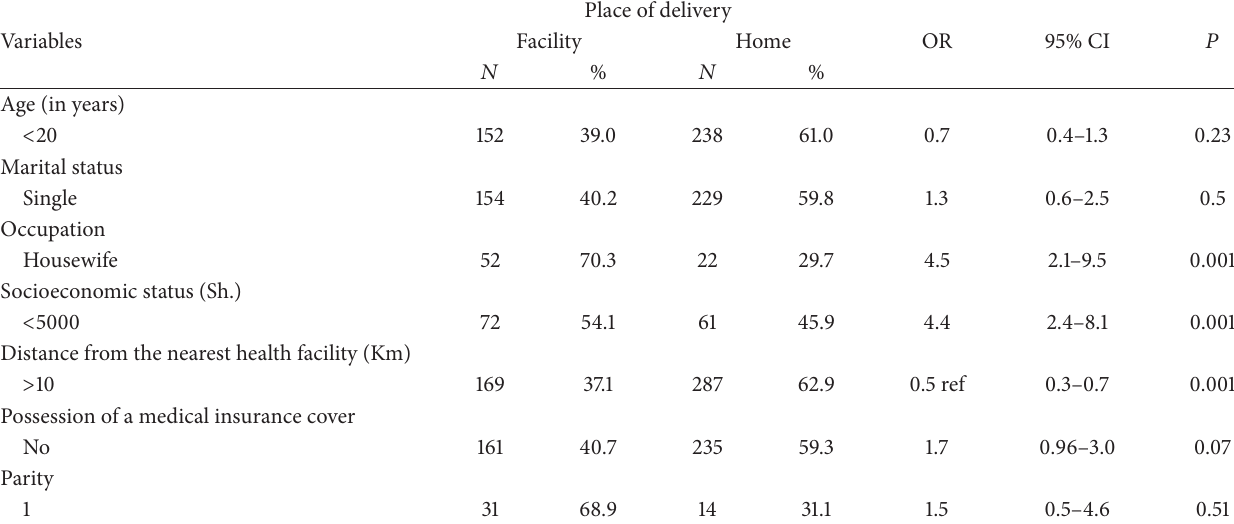
Table 2: Multivariate analysis of predictors of place of